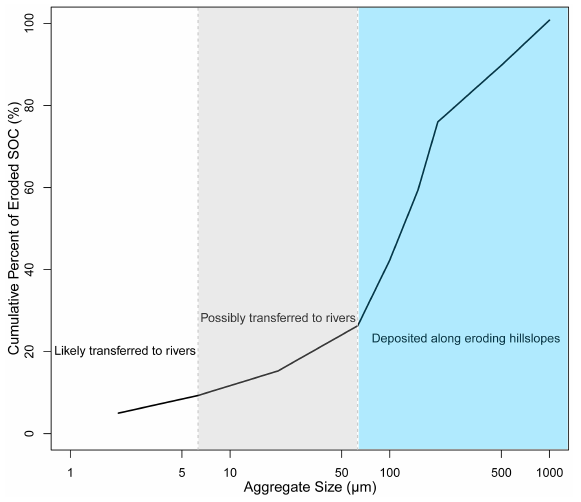
Figure 6. Likely fate of eroded soil organic carbon (SOC) as a func- tion of aggregate size, re-drawn from the conceptual model devel- oped by Starr et al. (2000). Blocks of different colors represent three manners of likely fate of eroded SOC, divided by the two conve- nient cutoff points: aggregate size of 6.3 and 63µm. See Sect. 4.1 for definitions and explanation of the three manners of likely